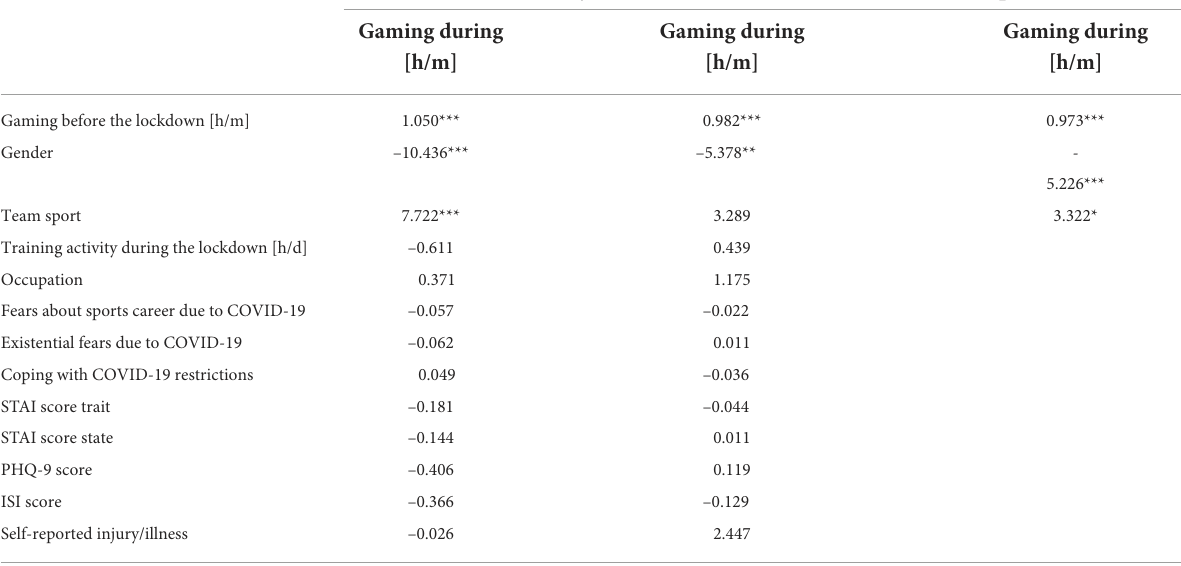
TABLE 4 Coefficients of multivariable regression of gaming time during the